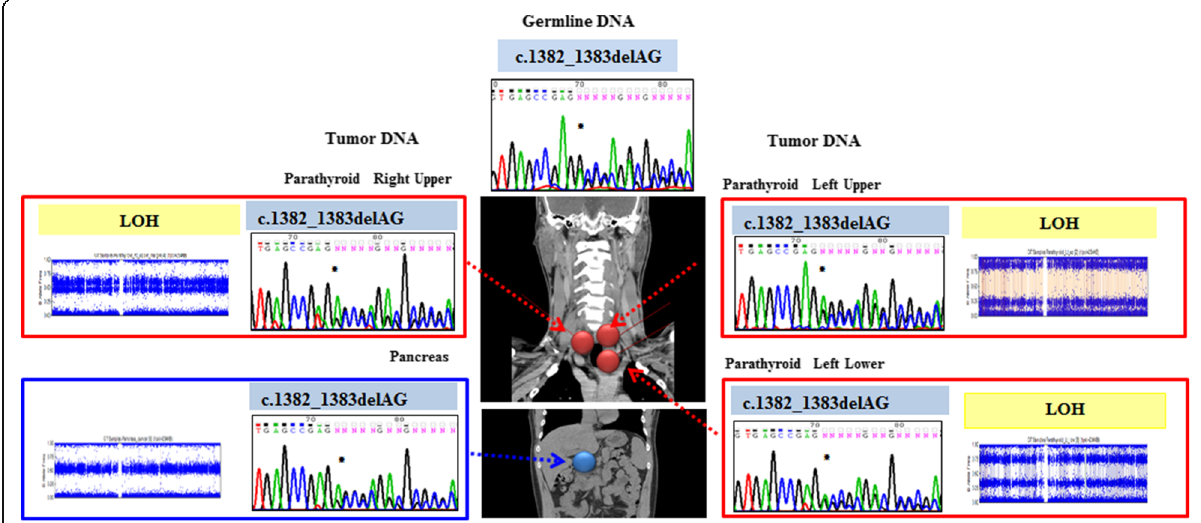
Fig. 3 Analysis of multiple endocrine tumors from the same patient. Computed tomography scans and the various nodules present on both the parathyroid glands (red arrow) and pancreas (blue arrow) of the same patient are shown. Each nodule shows the germline defect (blue). A second alteration (yellow) differed between the parathyroid gland and